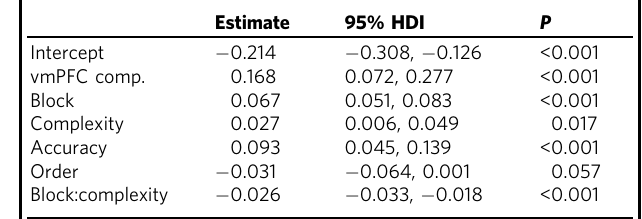
Table 5 Results of the Bayesian-estimated linear mixed effects regression model relating attention and vmPFC